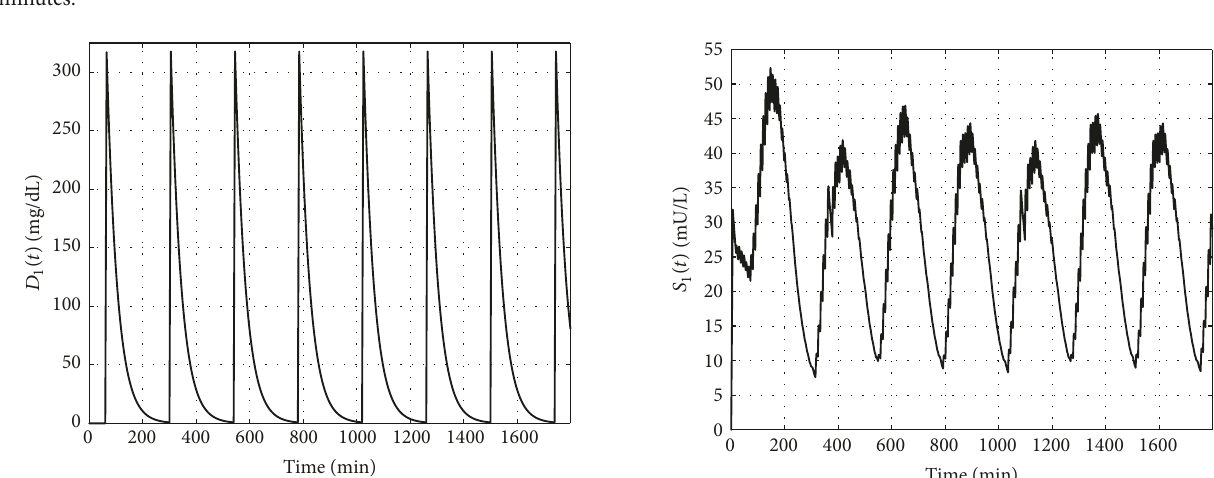
Figure 11: Calculated control signals. (a) represents the whole time horizon. (b) shows a piece of the whole time horizon between 0 and 40 minutes.